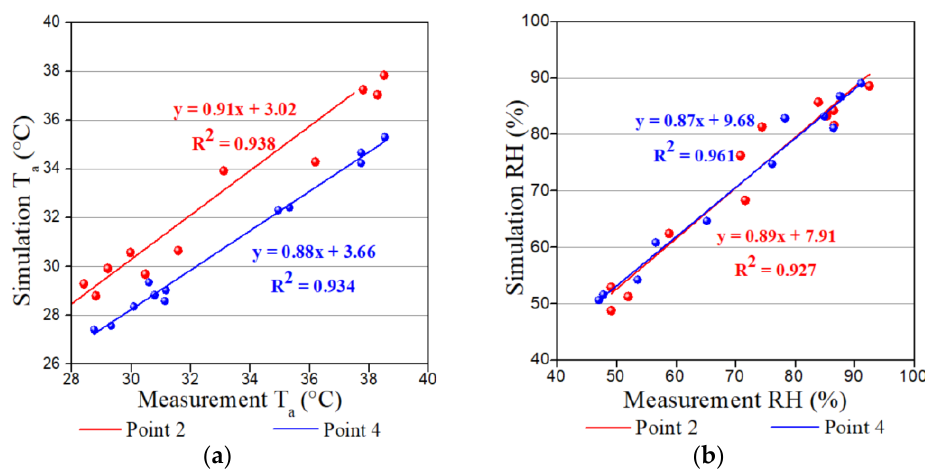
Figure 9. Regression results between measured and simulated values of ( a ) temperature and ( b ) relative humidity.